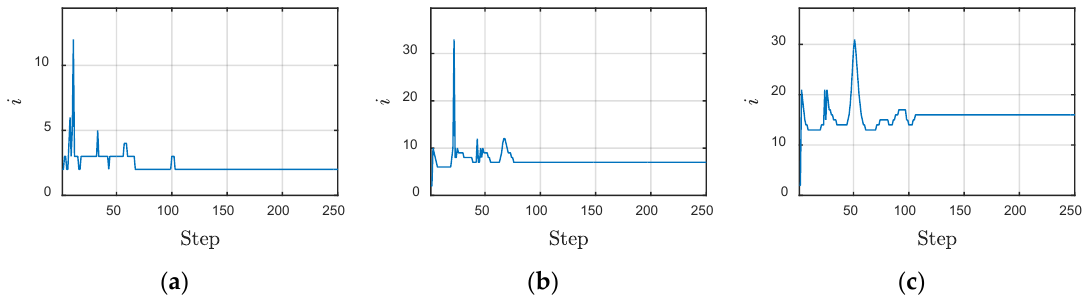
Figure 17. The convergence behavior of Aitken relaxation: ( a ) e s = 10 −13 , e f = 10 −13 ; ( b ) e s = 10 −14 , e f = 10 −14 ; and ( c ) e s = 10 −15 , e f = 10 −15 .